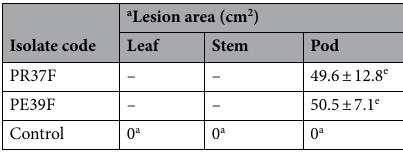
Table 1. Lesion area produced on the leaves, stems and pods of Theobroma cacao inoculated with Lasiodiplodia theobromae . a Means ± standard deviation followed by different letters are significantly different (p < 0.05) according to Tukey’s test. b Not